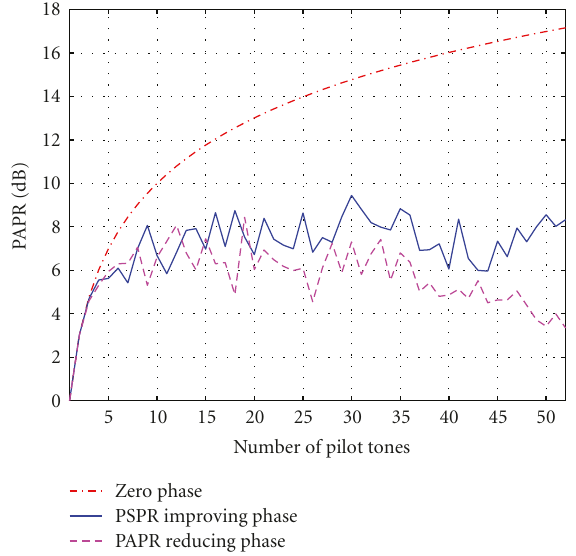
Figure 12: PAPR comparison of waveforms generated using zero, PSPR improving, and PAPR reducing